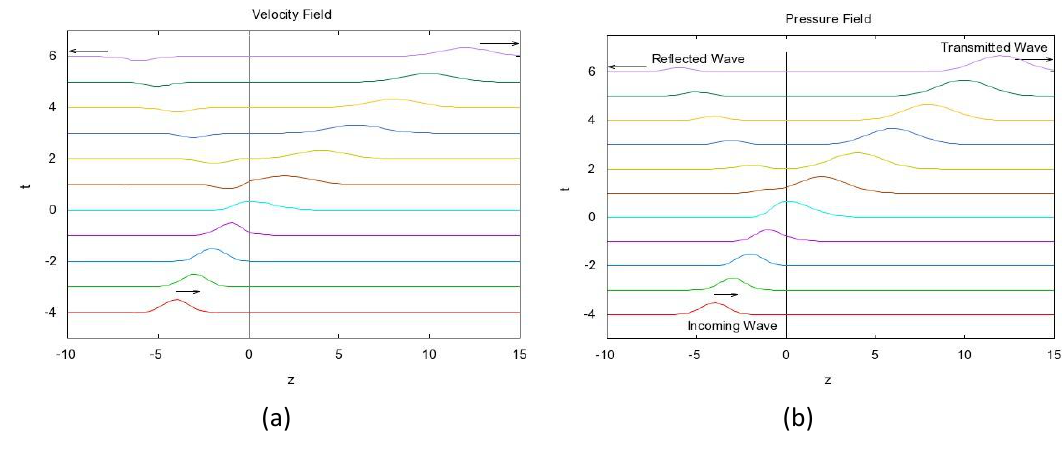
Figure 4. Scattering of a pulse by an interface separating two homogeneous half-spaces ( c , ζ , z < 0) and ( c , ζ , z > 0). Here the incoming right-going wave has a Gaussian profile, 0 0 1 1 c = ζ = 1, and c = ζ = 2. The spatial profiles of the velocity field (a) and of the pressure 0 0 1 1 field (b) are plotted at times t = −4, t = −3,..., t =